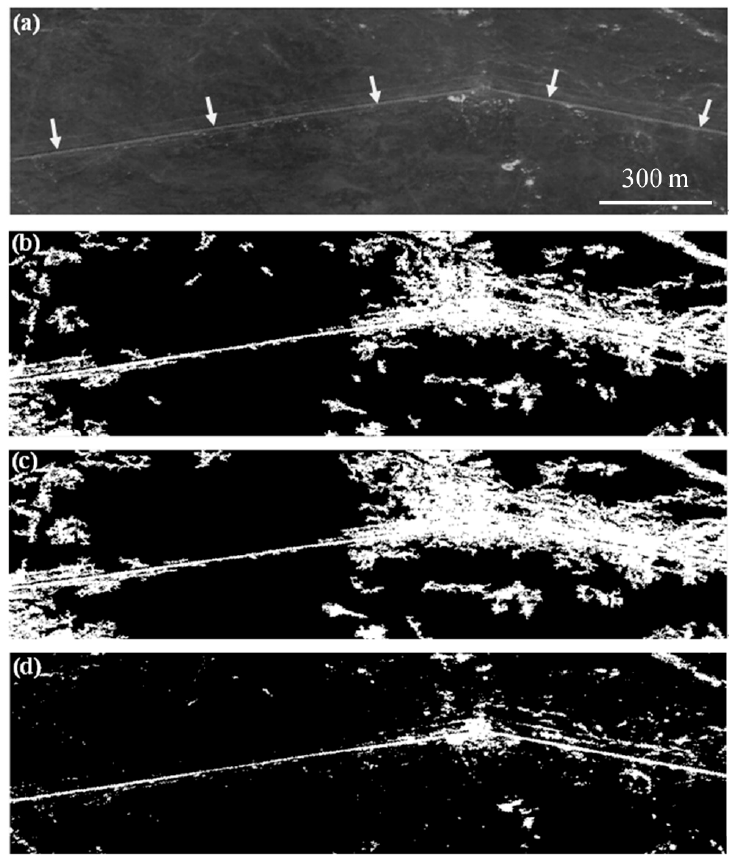
Figure 8. Threshold-based segmentation results for the GF-1 PAN sub-image: ( a ) original image, ( b ) original image after 2-Mode, ( c ) original image after Iteration and ( d ) original image after applying Otsu’s method with geometric filtering. The white arrows in ( a ) indicate linear traces of GH.